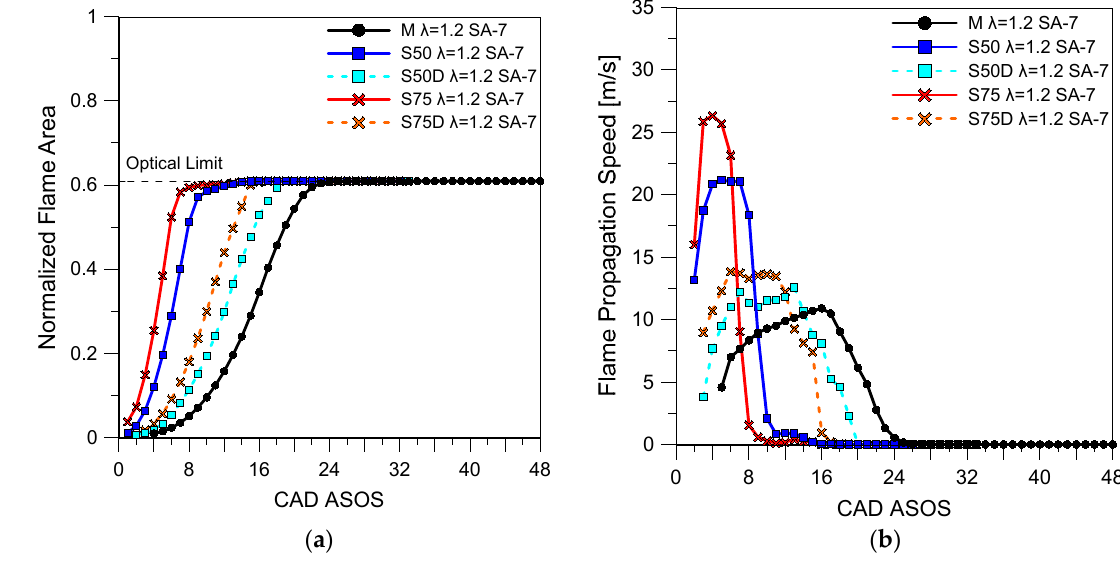
Figure 15. Average flame front evolution in terms of normalized area (cross-section piston area) and flame propagation speed for intermediate lean air-fuel ratio and five different fuels.